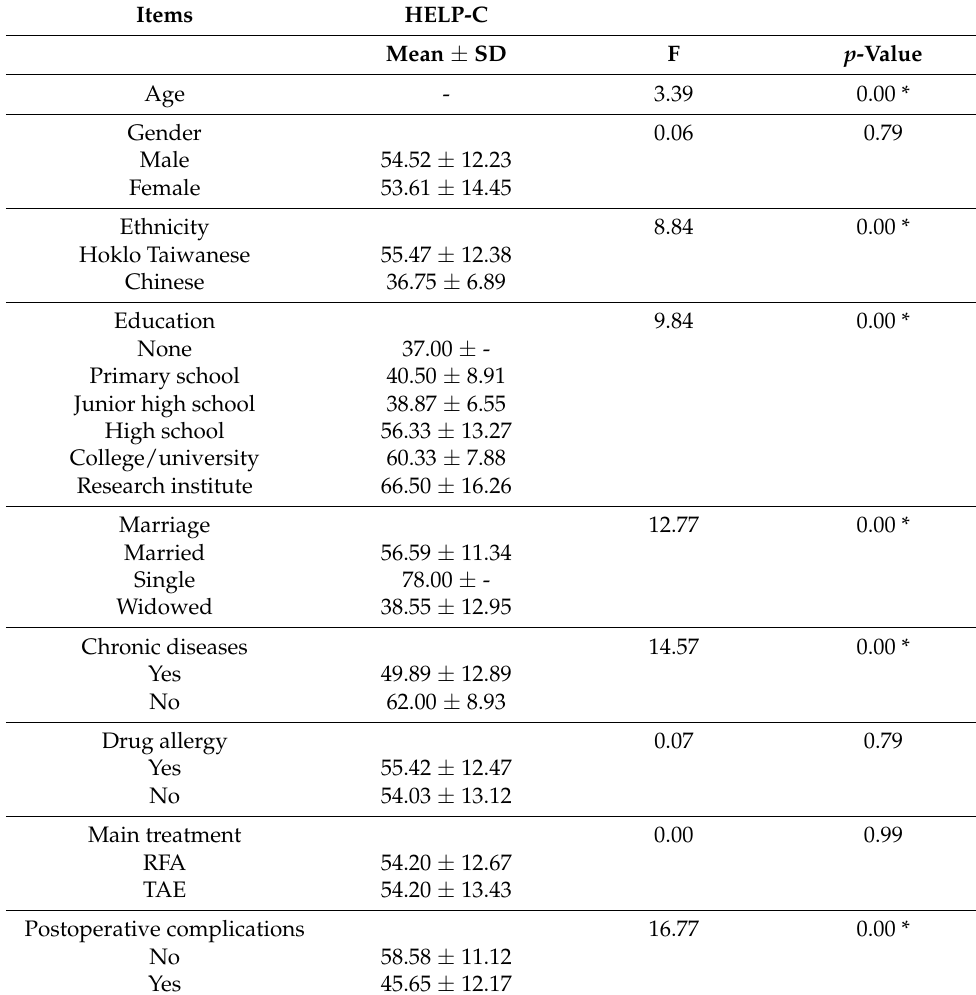
Table 2. Demography of participants and HELP-C scores (N =